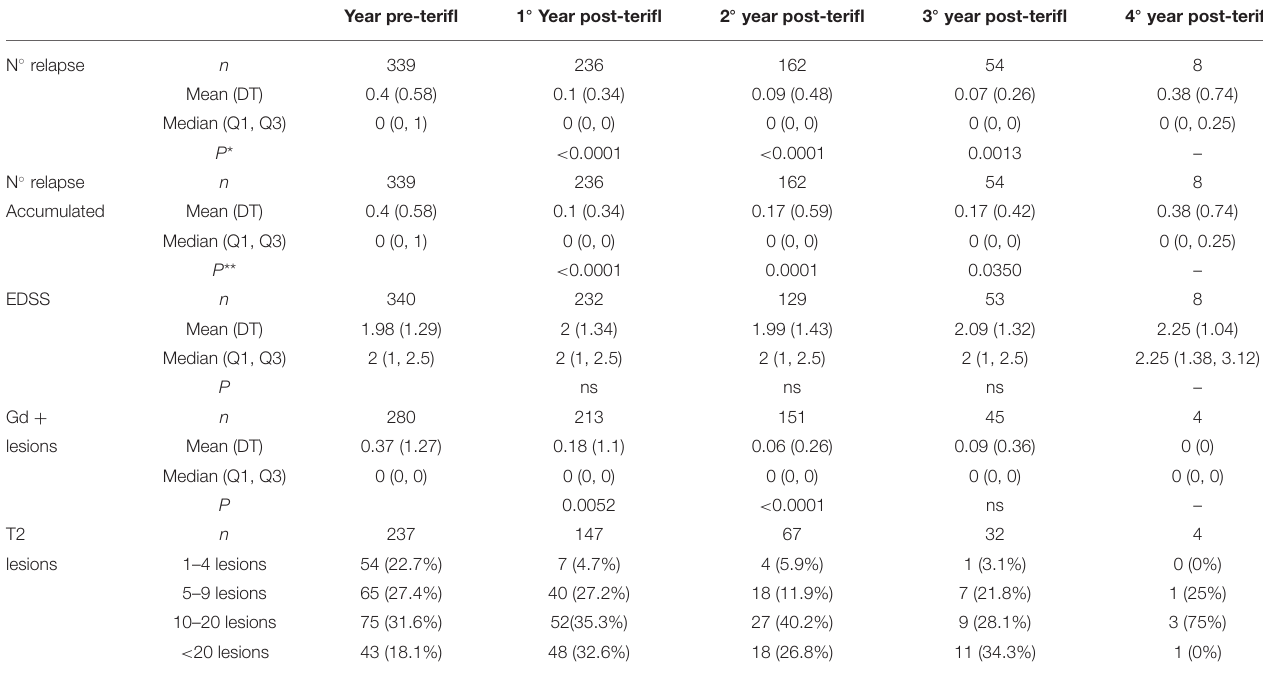
TABLE 2 | Results, clinical, and radiological